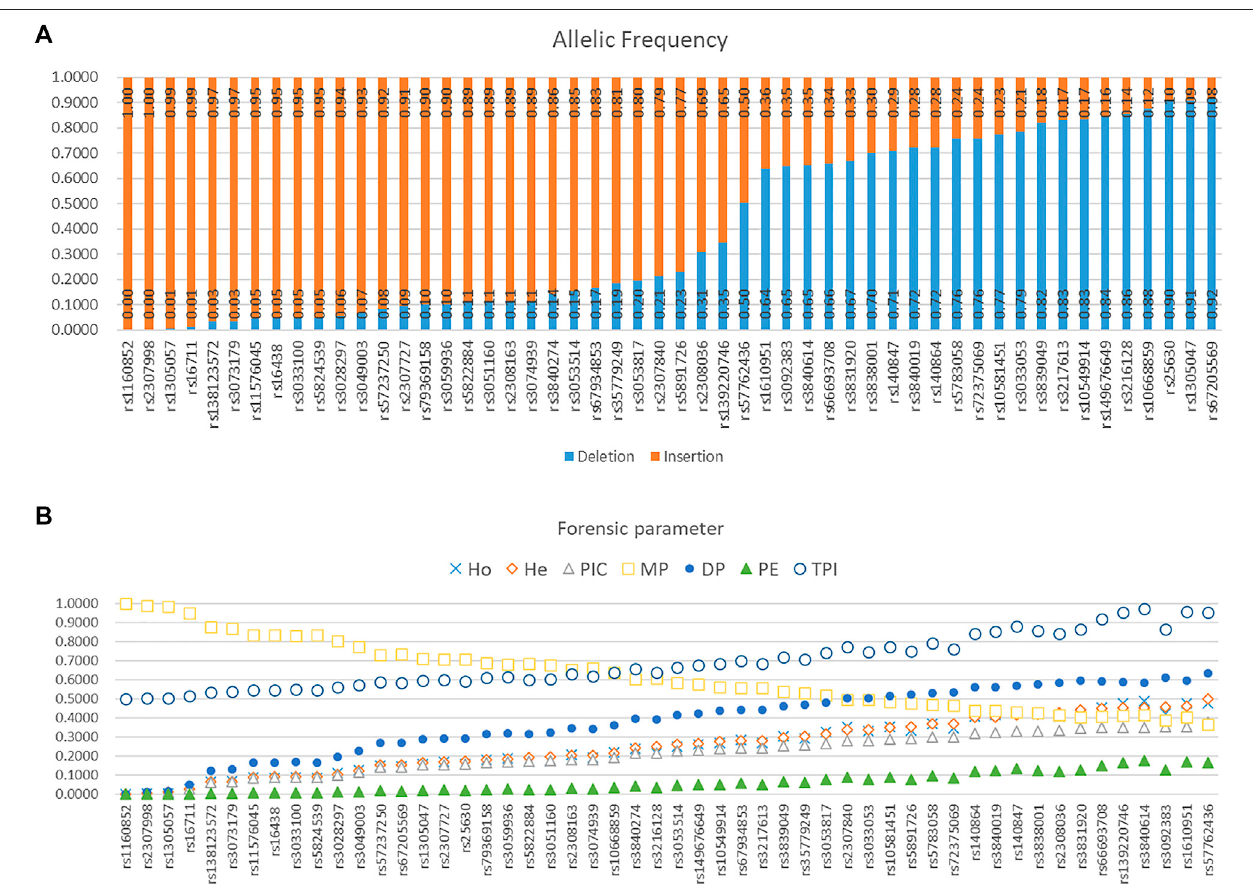
FIGURE5| Allelicfrequenciesandforensicparameters of52ancestryinformativeDIPsinanEasternHanpopulation. (A) Allelicfrequency. (B) Forensicparameter.